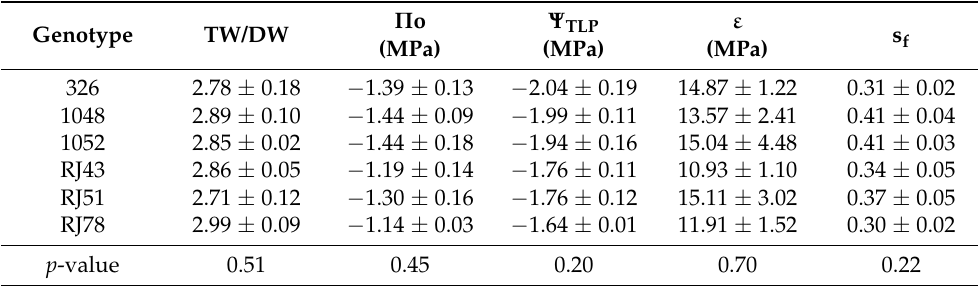
Table 3. Average turgor weight divided by dry weight (TW/DW), osmotic potential at full turgor and at turgor loss point ( π of and π TLP ), elasticity modulus ( ε ) and symplastic pathway (s f ) values for each